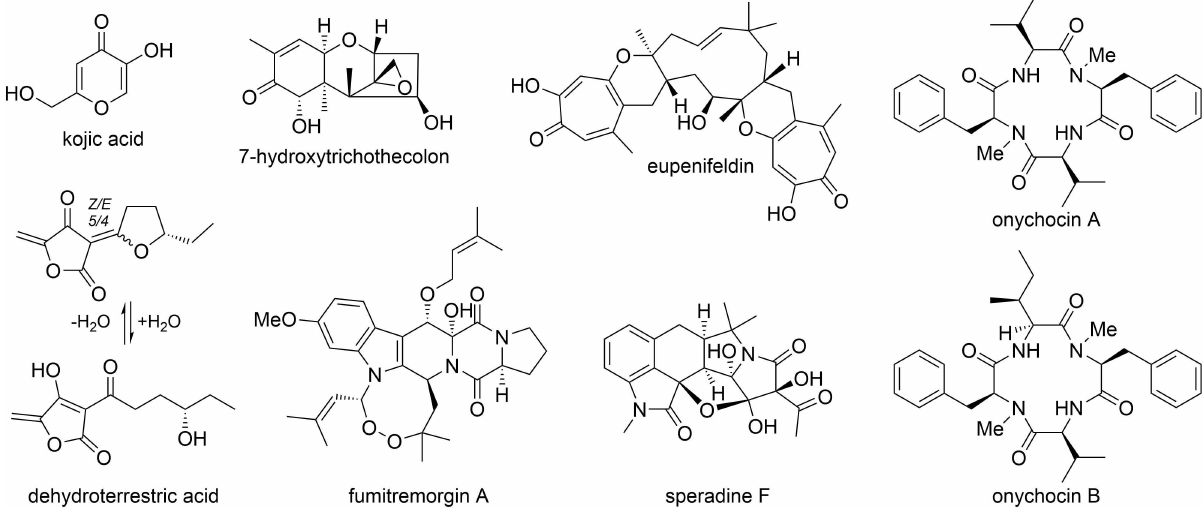
Fig 3. Metabolites isolated from Aspergillus hancockii